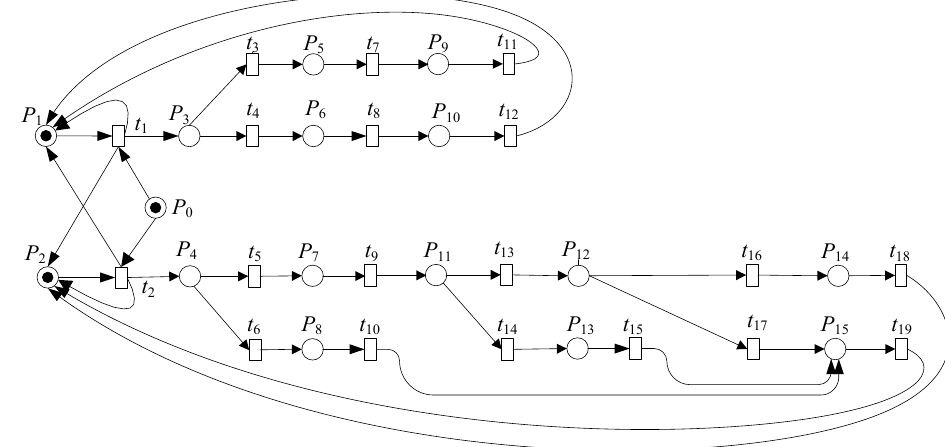
Figure 5. SPN model of LTE-R time synchronization process under attack.